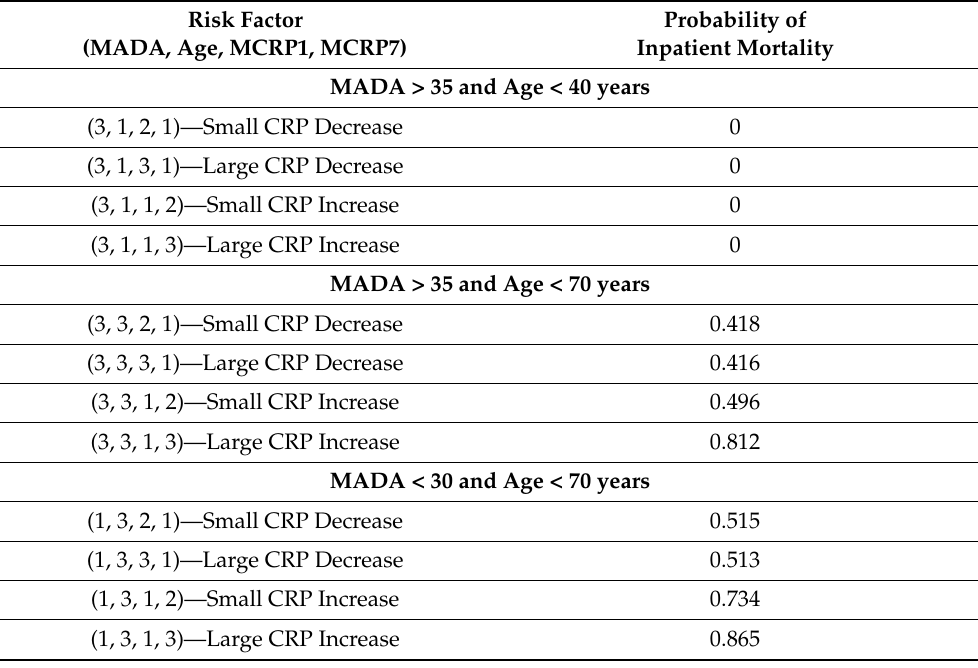
Table 5. The conditional probability of IPD given different configurations of MADA, Age, MCRP1 and MCRP7.